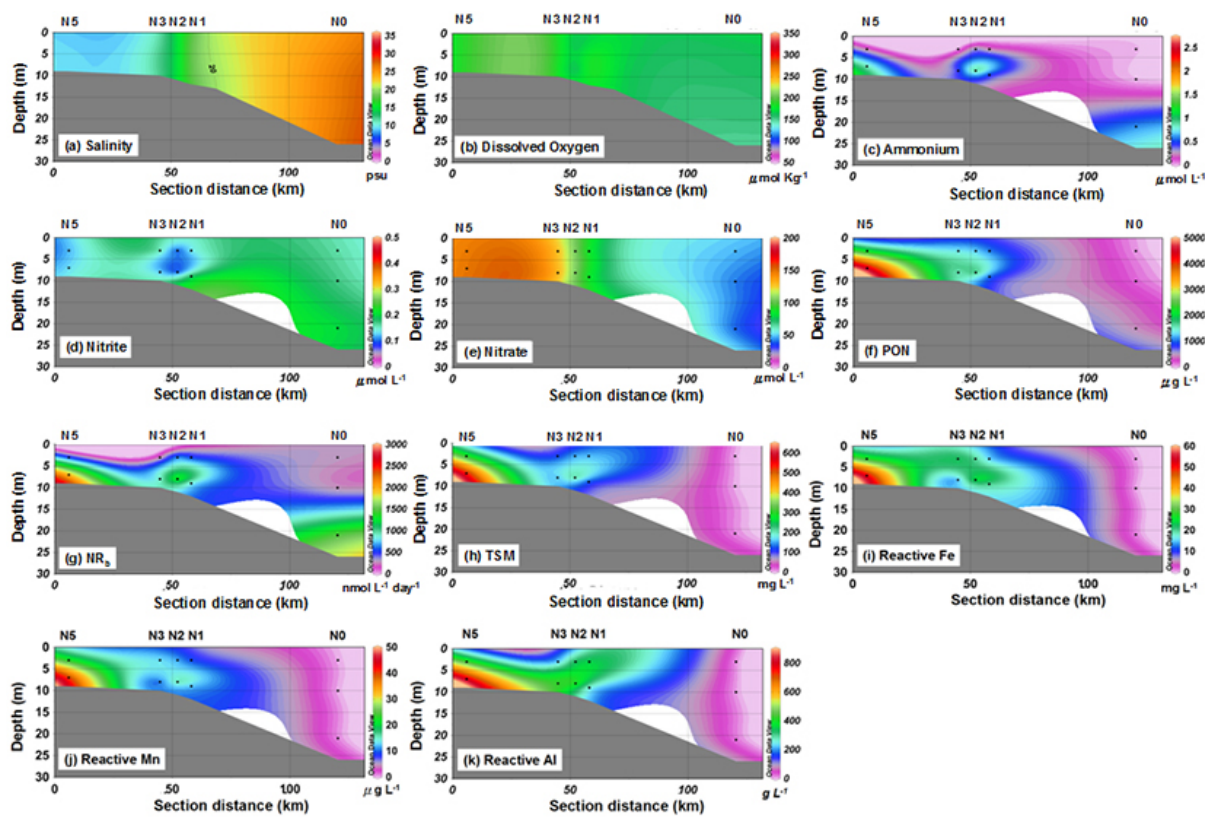
Fig. 3. Transects of (a) salinity, (b) dissolved oxygen, (c) ammonium, (d) nitrite, (e) nitrate, (f) particulate organic nitrogen (PON), (g) bulk nitrification rate (NR b ), (h) total suspended material(TSM), (i) reactive Fe, (j) reactive Mn, (k) and reactive Al across the Qiantang river mouth. The color mapping represents the same range of data as in Fig. 2 except for PON, TSM and reactive Fe. Salinity and dissolved oxygen were obtained continuously by CTD. Discrete sampling depths of other parameters are indicated by black dots. Data were plotted using the DIVA gridding in ocean data view v.4.3.2 (http://odv.awi.de,